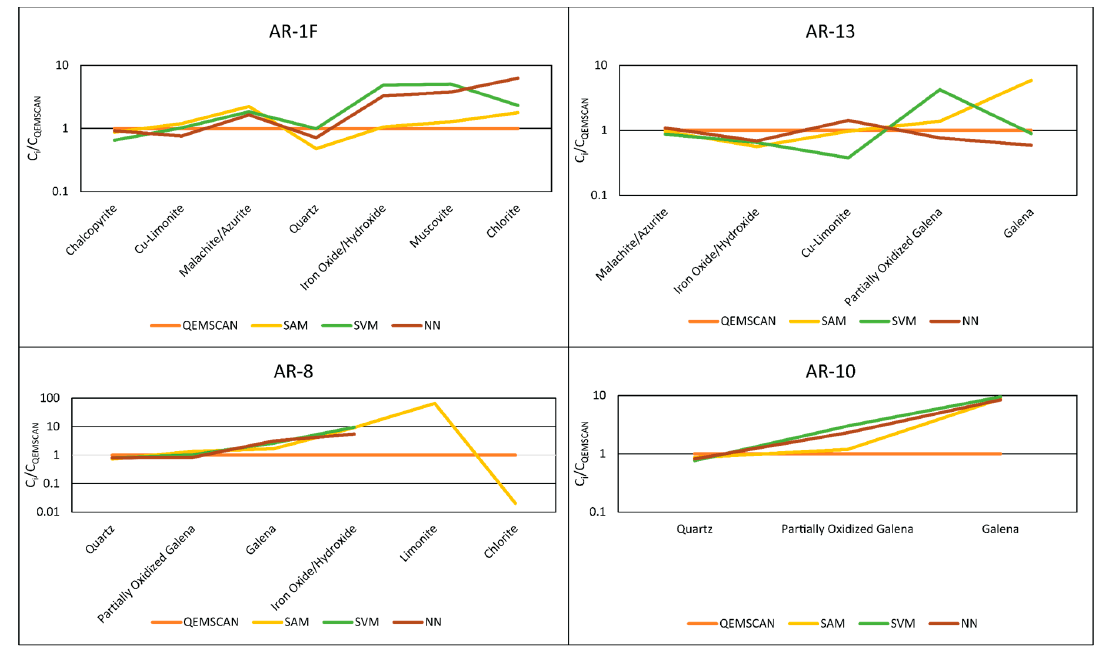
Figure 9. Comparison of compositions obtained by different classification techniques. The ratio of the composition obtained by each technique to the abundance determined by QEMSCAN is shown— C i / C QEMSCAN ( i = SAM, SVM, NN) A log scale is used for the y -axis.